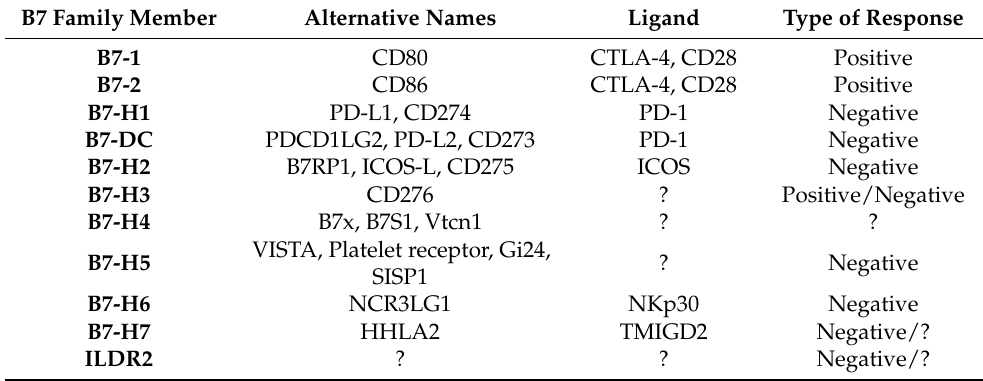
Table 1. The members of B7 family checkpoints and their alternative names, ligands, and type of response. B7 Family